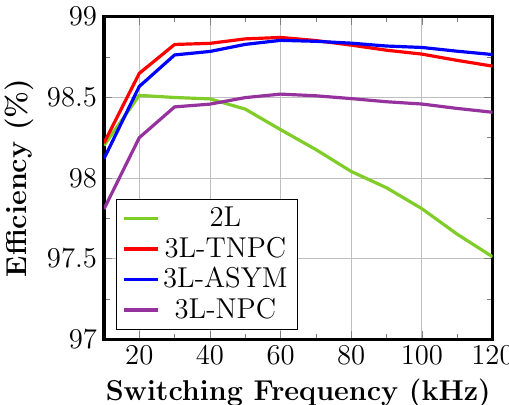
Figure 15. VSAPF efficiency function of the switching frequency. VSAPF injecting rated compensating current I C = 33.5 A (rated power rating 23.1 kVA) (Based on the work in [1]).